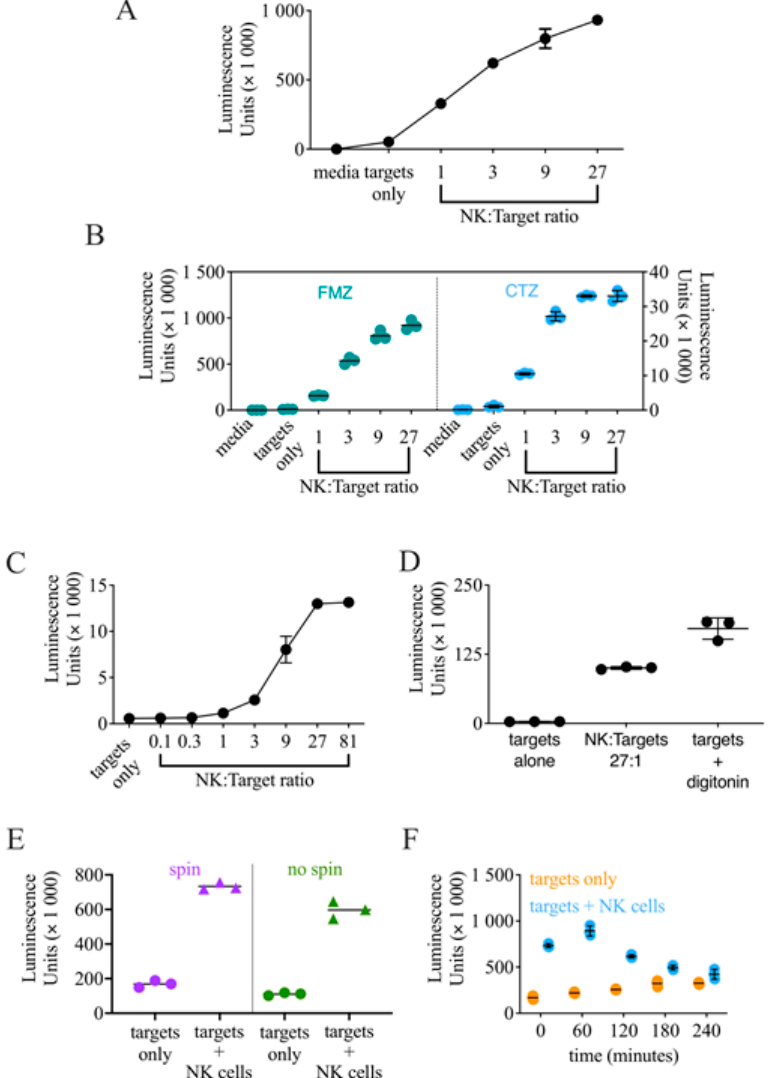
Figure 1. Optimization of a luciferase release-based cytotoxicity assay for a high-throughput screen. NK92 cells were co-cultured with K562-NL cells at the indicated E:T ratios for 5-h at 37 °C. After incubation, the supernatant was collected, the indicated substrate added, and luminescence read by Biotek Synergy (Winooski, WI, USA) microplate reader. ( A ) Luciferase-release cytotoxicity assay using transduced K562-NL cells (bulk population, unsorted). Twenty thousand K562-NL targets per well. After the incubation, luciferase activity was measured using FMZ (Promega Nano-glo, Madison, WI, USA) luciferase assay system. Mean +/ − SD of three technical replicates. ( B ) After the incubation, luciferase activity was measured after addition of either FMZ luciferase assay sys- tem or CTZ substrate. Ten thousand K562-NL targets per well. Mean +/ − SD of three technical replicates. Representative of 3 biological replicates. ( C ) Luciferase-release cytotoxicity assay using 10,000 K562-NL cells. After the incubation, luciferase activity was tested after addition of CTZ. Mean +/ − SD of three technical replicates. Graph is representative of 2 biological replicates. ( D ) K562-NL cells were treated with 30 µ g/mL digitonin and compared to K562-NL cells co-cultured at an E:T ratio of 27. Ten thousand K562-NL cells per well. Luciferase activity was tested after addition of CTZ. Mean +/ − SD of three technical replicates. Representative of 2 biological replicates. ( E ) Super- natant from a cytotoxicity assay was either collected directly or collected after a centrifugation step. Three technical replicates are shown. Representative of 2 biological replicates. ( F ) NK92 or K562-NL cells were incubated at room temperature at indicated times (minutes) prior to start of a cytotoxicity assay. Mean +/ − SD of three technical replicates. Representative of 3 biological